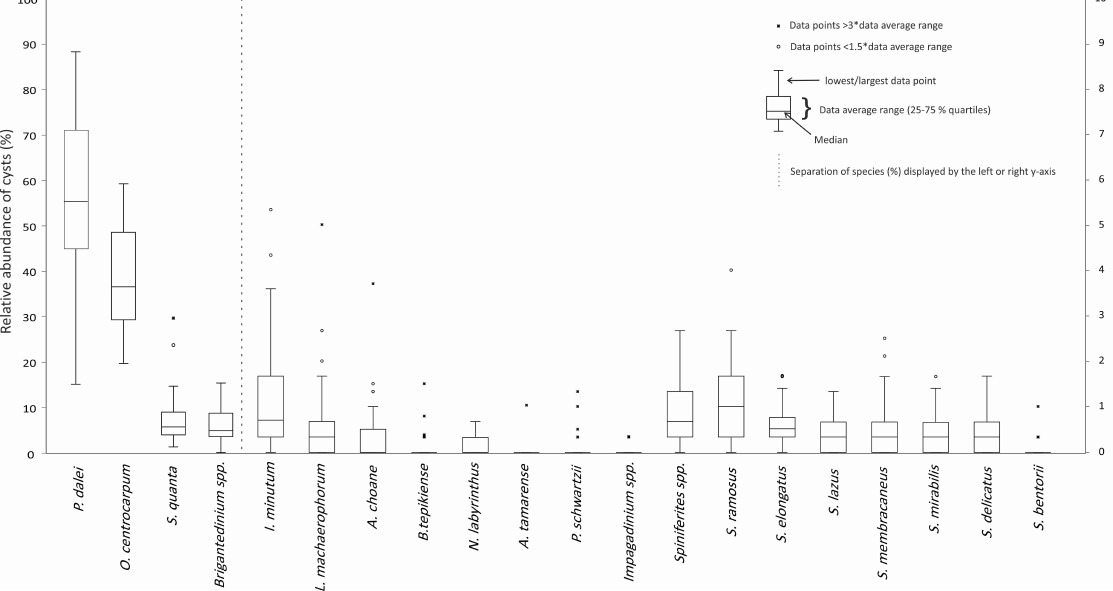
Fig. 7. Distributional ranges (%) of dinocyst species in the Trondheimsfjord surface sediments using the software package PAST by Hammer et al.